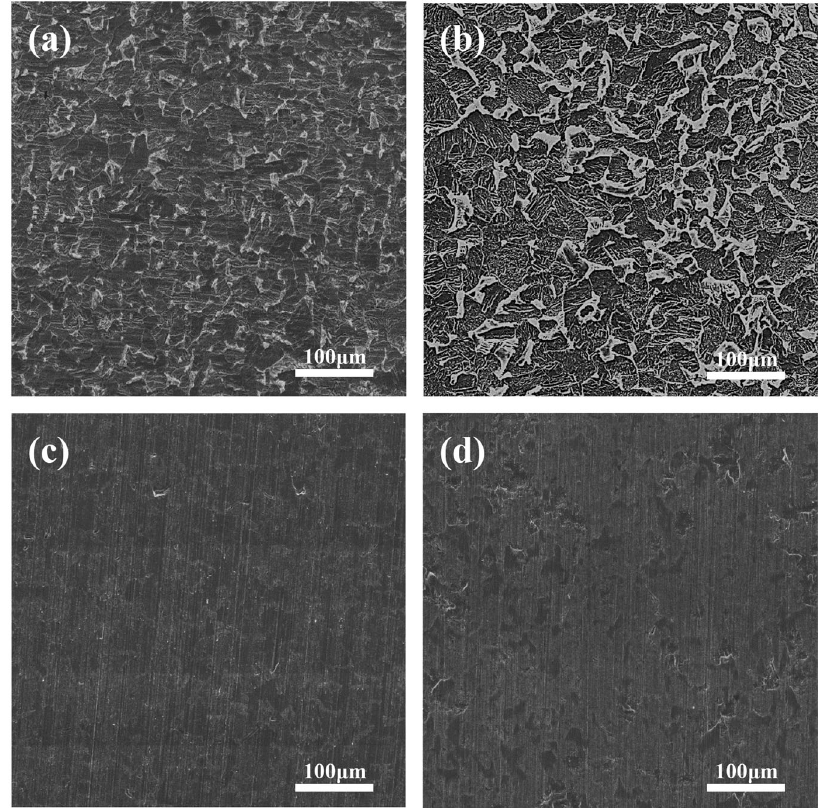
Fig. 2 SEM images of Q235 coupons after removing the surface products. a , b Q235 surface in the sterile medium after 7 days and 14 days; c , d Q235 surface in S. putrefaciens -inoculated medium after 7 days and 14 days.